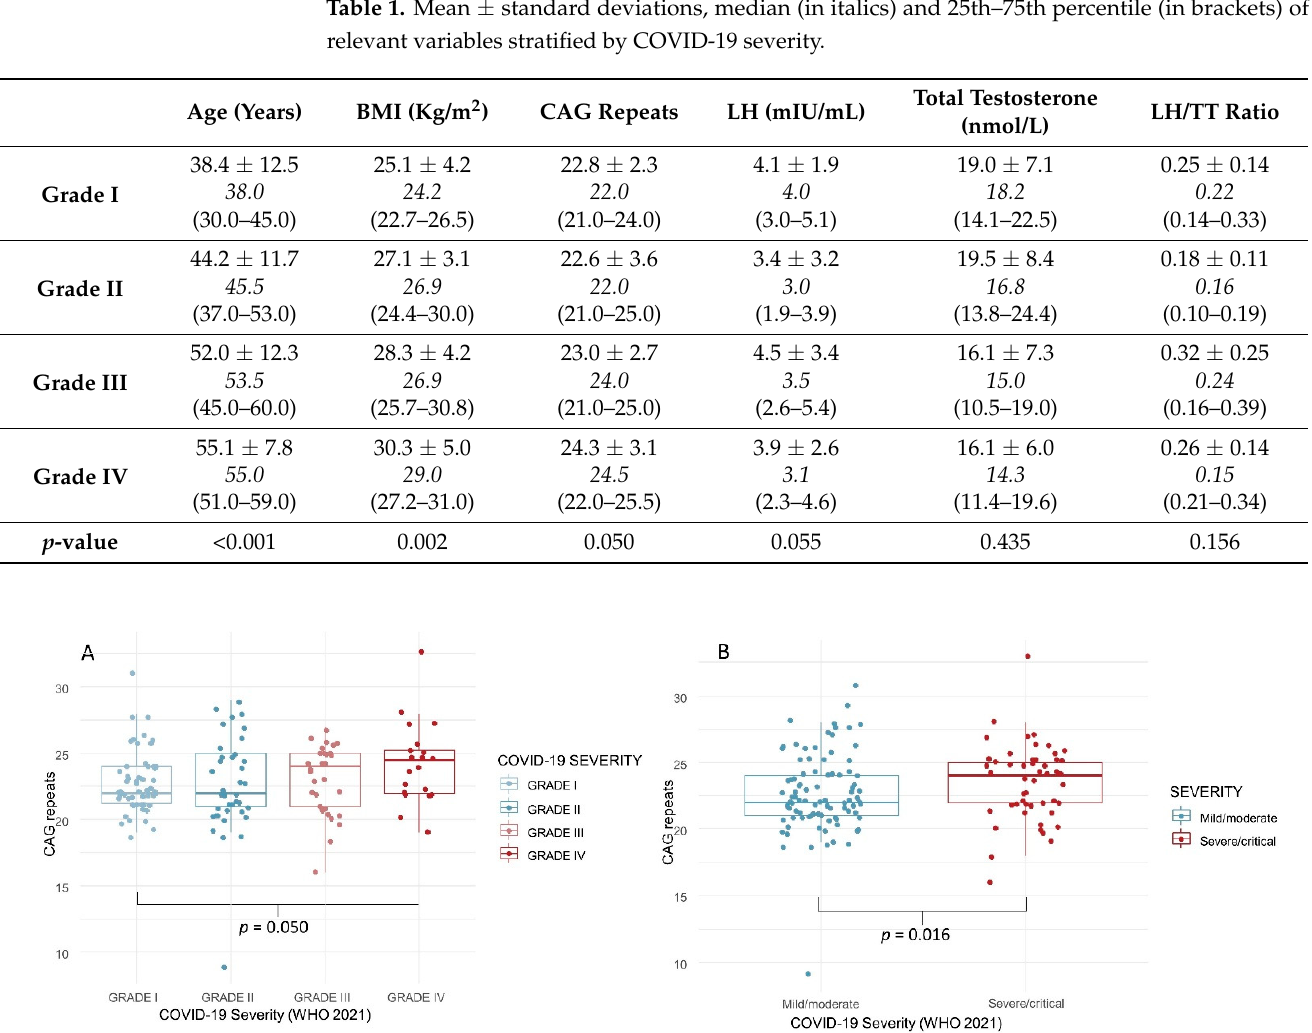
Figure 3. Number of CAG repeats in COVID-19 survivors, according to disease severity (4 grades, ( A ); 2 grades, ( B )).